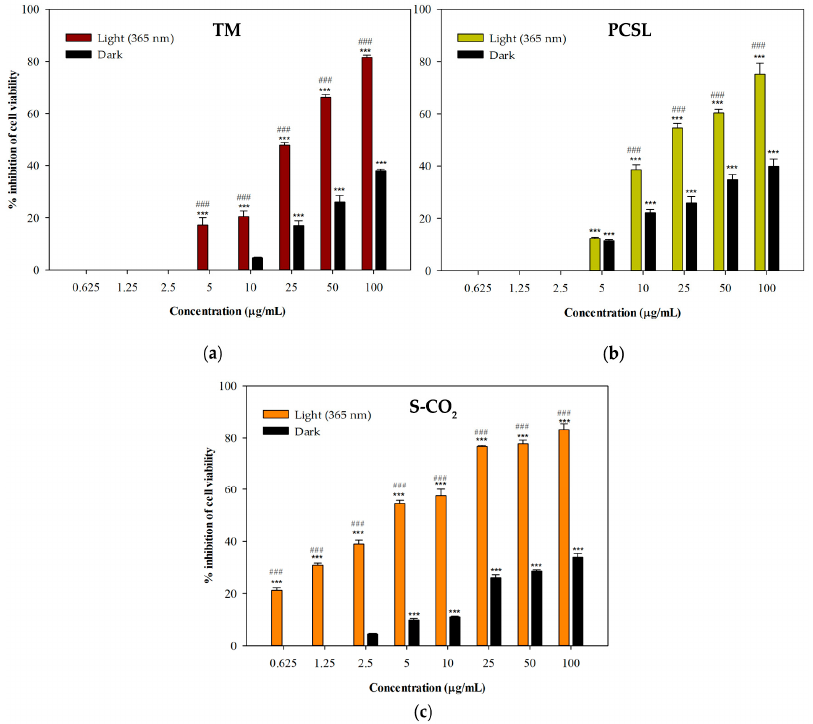
Figure 5. Concentration-dependent photocytotoxic effects and dark toxicity of P. ferulacea Lindl. extracts. ( a ) Traditional maceration, TM; ( b ) pressurized cyclic solid–liquid extraction (PCSL); ( c ) su- percritical CO 2 extraction (S-CO 2 ); *** p < 0.001 compared to control (Dunnett’s test); ### p < 0.001 compared to cytotoxic effects in the dark. The cell morphology 48 h after treatment and UVA irradiation was captured on a digital camera (Figure 6).